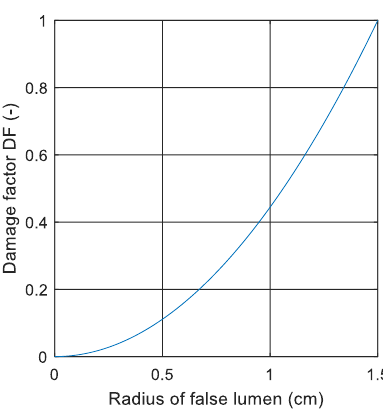
Fig.7: Flow disturbances around the dissection in case of an aortic dissection.